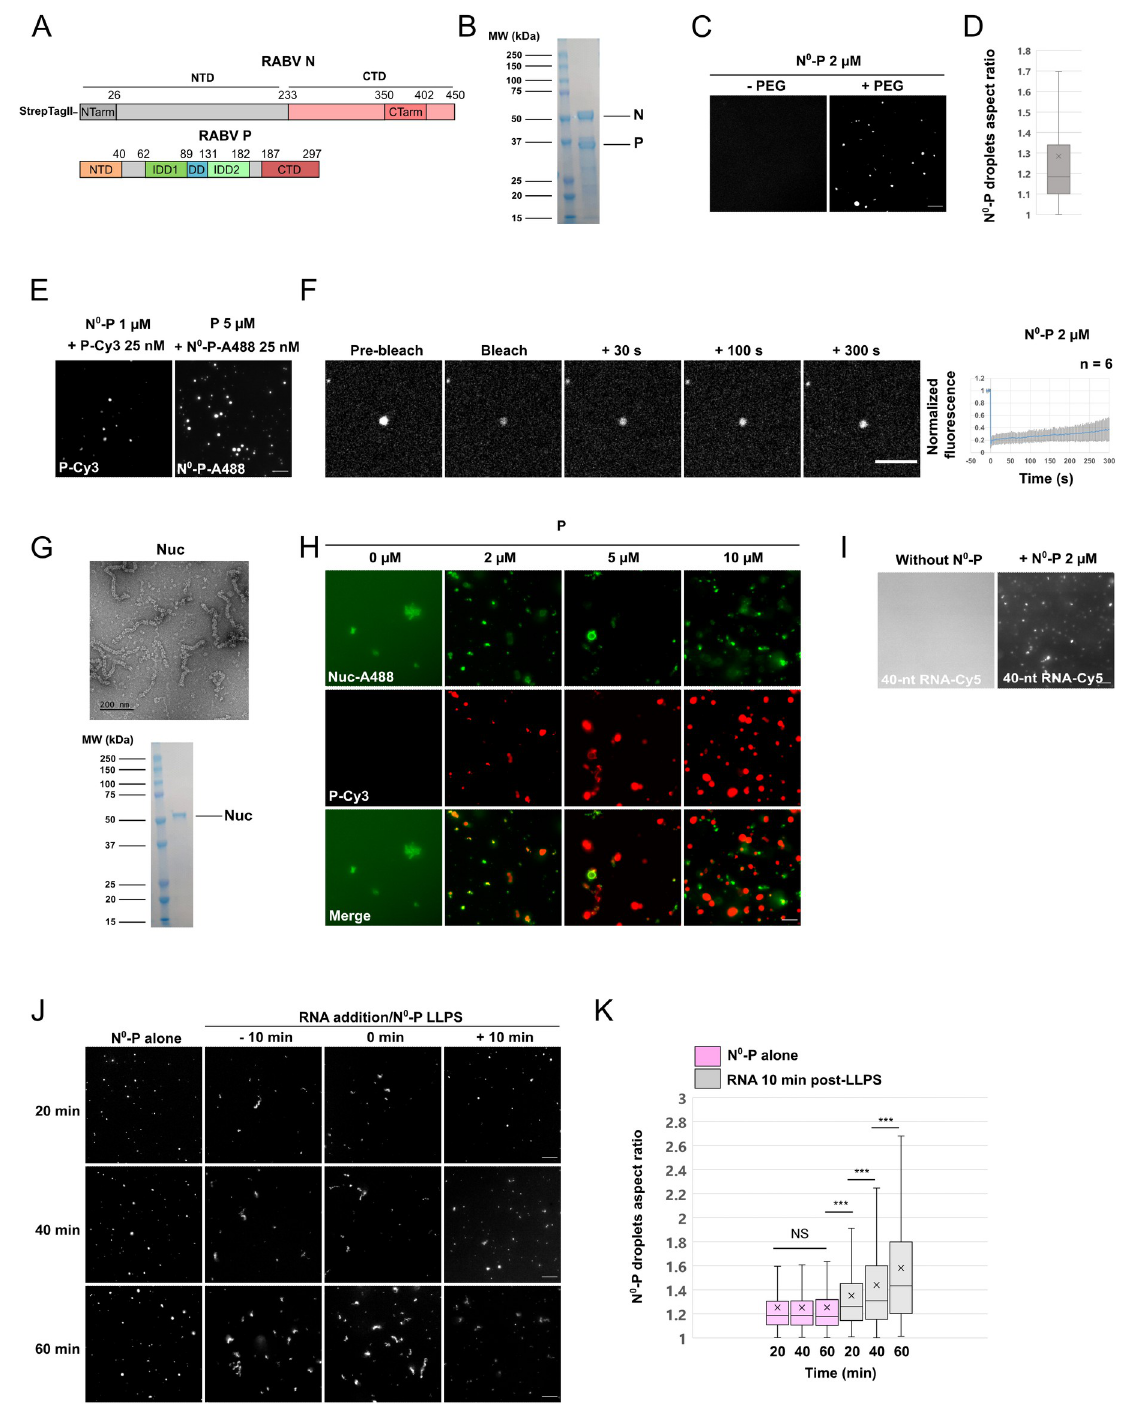
Fig 7. Characterization of the behavior of RABV N in acellular minimal systems. A) Schematic representation of the organization of RABV N and P constructs used. A StrepTagII was amino-terminally fused to the N protein to purify the N0-P complex from insect cells. Domains delimitations are indicated for both proteins. B) SDS PAGE analysis of N0-P complex. C) Purified N0-P complex labelled with NHS-Ester-Atto-488, was incubated at 2 μ M concentration in 50 mM NaCl, 20 mM Tris-HCl pH 7.5 in absence or presence of 5% PEG 8000. Presence of N˚-P droplets was assessed by fluorescence microscopy. Scale bar: 10 μ m. D) Box plot representation of N˚-P droplets aspect ratios (formed at 2 μ M with 5% PEG 8000 as in C). Sample size: n = 1707. The cross on the boxplot indicates the mean. E) Fluorescent P (resp. fluorescent N0-P) at 25 nM was incubated with 1 μ M N0-P (resp 5 μ M P) in 50 mM NaCl, 20 mM Tris-HCl pH 7.5